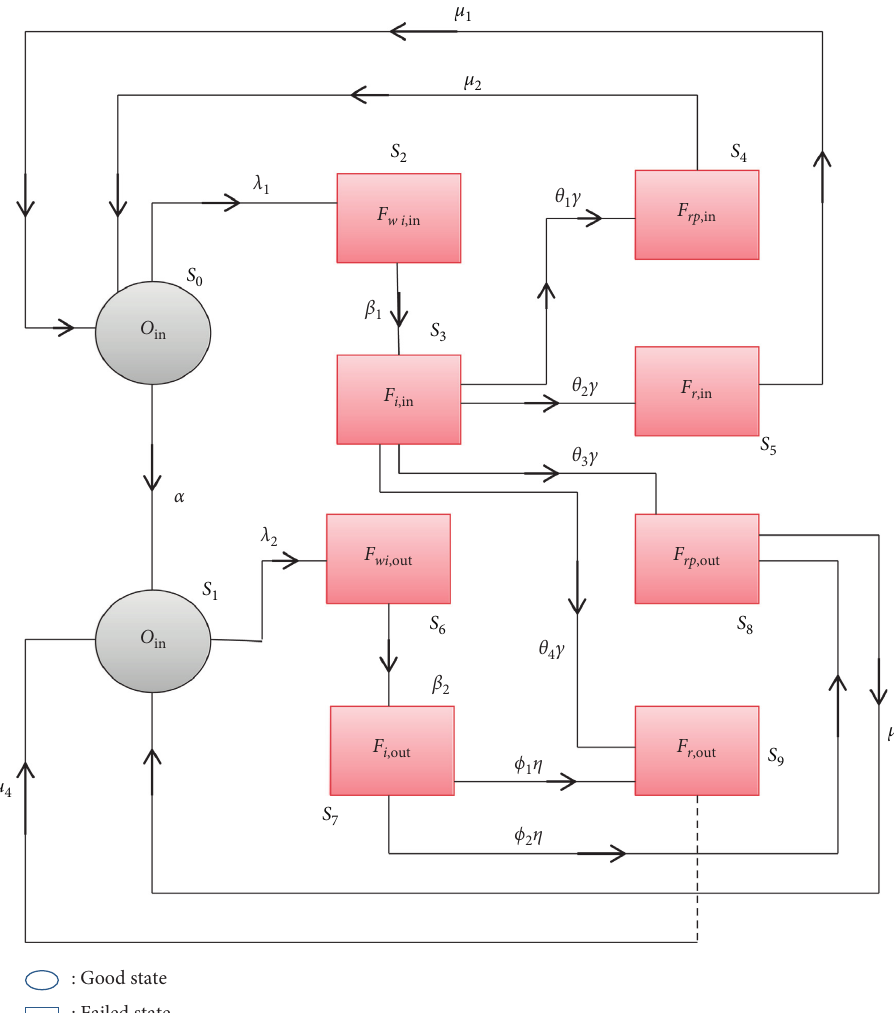
Figure 1: State-transition diagram of the